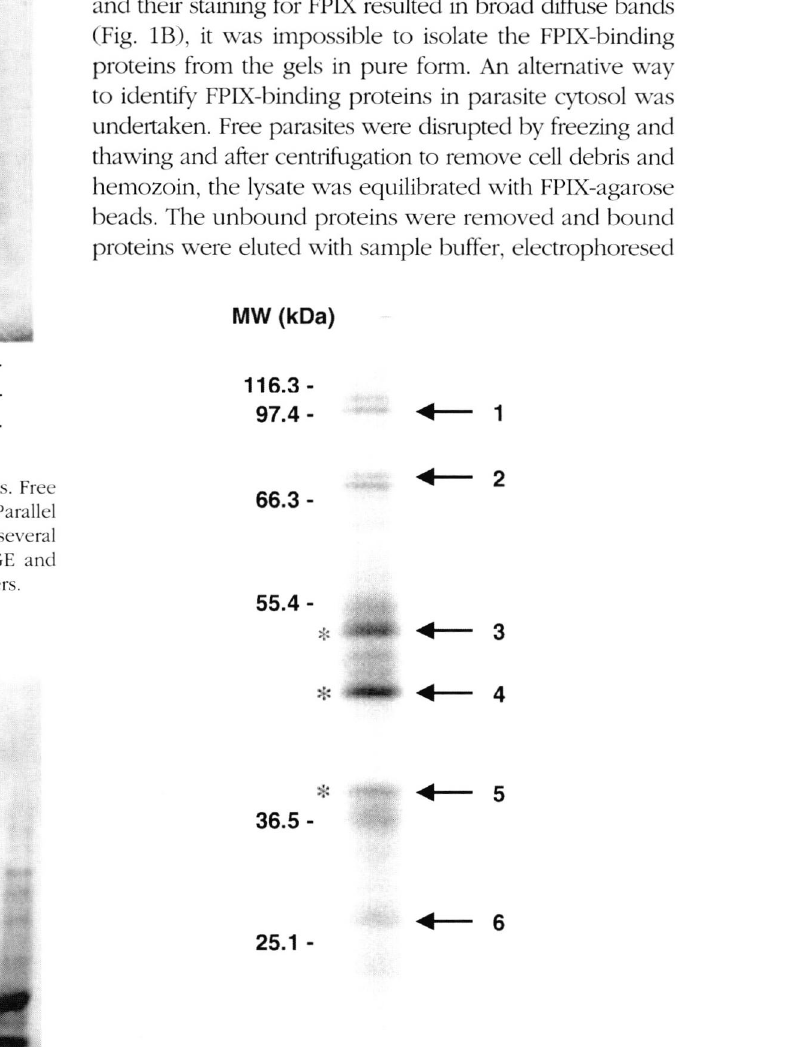
Fig. 4. - Identification of parasite proteins that bind to hemin-aga- rose beads. Trophozoites were freed from host cells, triturated and the super­ natant was exposed to hemin agarose beads as described in Mate­ rial and methods. Bound proteins were electrophoresed and stained for identification. Individual bands were cut out from the gels and Fig. 3. - Effect of verapamil and H O on CQ-induced association 2 2 their proteins were sequenced. Identification of bands: l - Hsp90; of FPIX with parasite proteins. 2 - Hsp70; 3 - enolase and elongation factor 1- α ; 4 - phoshogly- Infected cells were incubated for four hours at conditions described cerate kinase; 5 - glyceraldehyde 3-phosphate dehydrogenase; 6 - L- in the legend to Figure 1 without or with increasing concentrations lactate dehydrogenase and gametocytogenesis onset-specific protein. of CQ ± 10 uM verapamil, or with CQ + 80 µM H O . Parasites were 2 2 Bands labeled with * are also seen in the lysates of CQ-treated cells freed by saponin lysis, disnipted and the supernatant was electro­ (Fig. phoresed on SDS-PAGE. Gels were stained for FPIX.